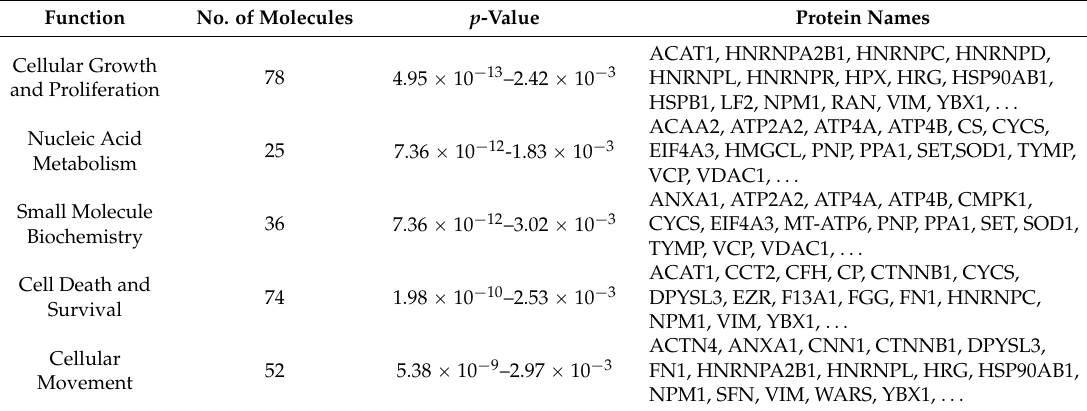
Table 2. Molecular and cellular function of dysregulated proteins analyzed by